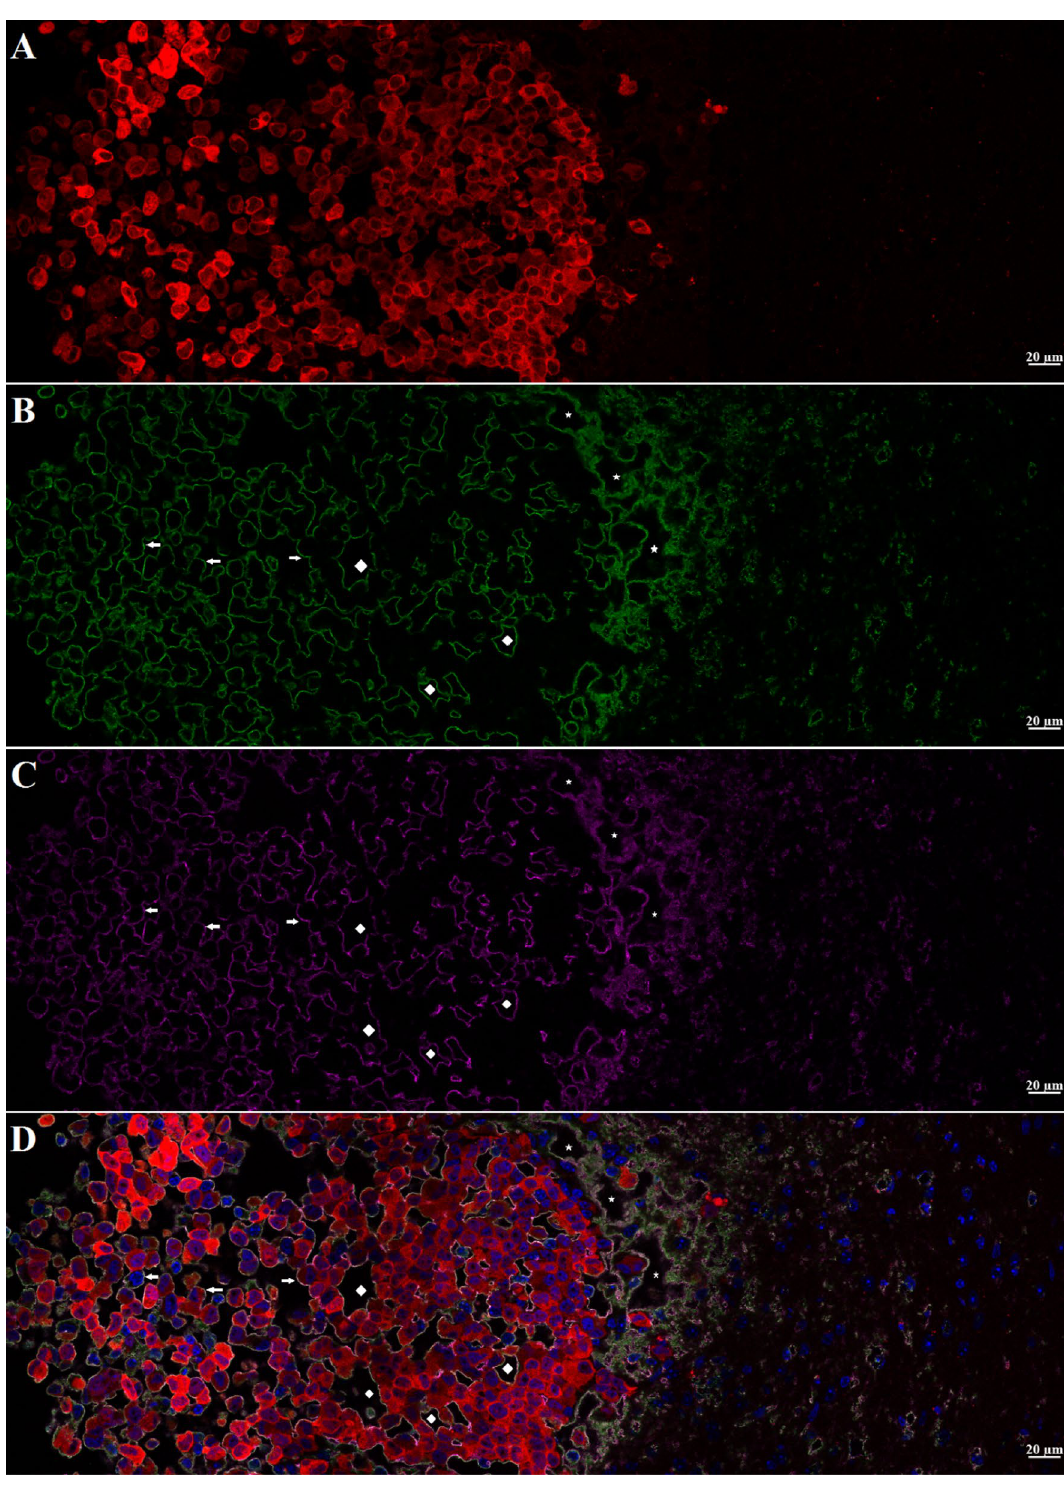
Figure 2. Higher magnification (63 ×) Confocal images of yellow boxed area shown in Fig. 1H. A – D : showing MBD-MD-231 tumor, tumor edge and peritumor area. A , tumor cells (td-Tomato, red); INPs (Anti PEG, green); Endothelial Marker (Anti-CD31, violet), D , all four colors merged with nuclei stained with DAPI, blue. Highest INP staining intensity colocalized with CD31 at the tumor edge and peritumor region compared to the tumor center. Arrows: Groups of tumor cells with grape cluster appearance. Irregularly shaped spaces (ISS) delineated by endothelial stains (asterisks and diamonds). Diamonds: Spaces formed are contributed by tumor cells only Asterisks: Spaces formed are contributed by both tumor and non-tumor